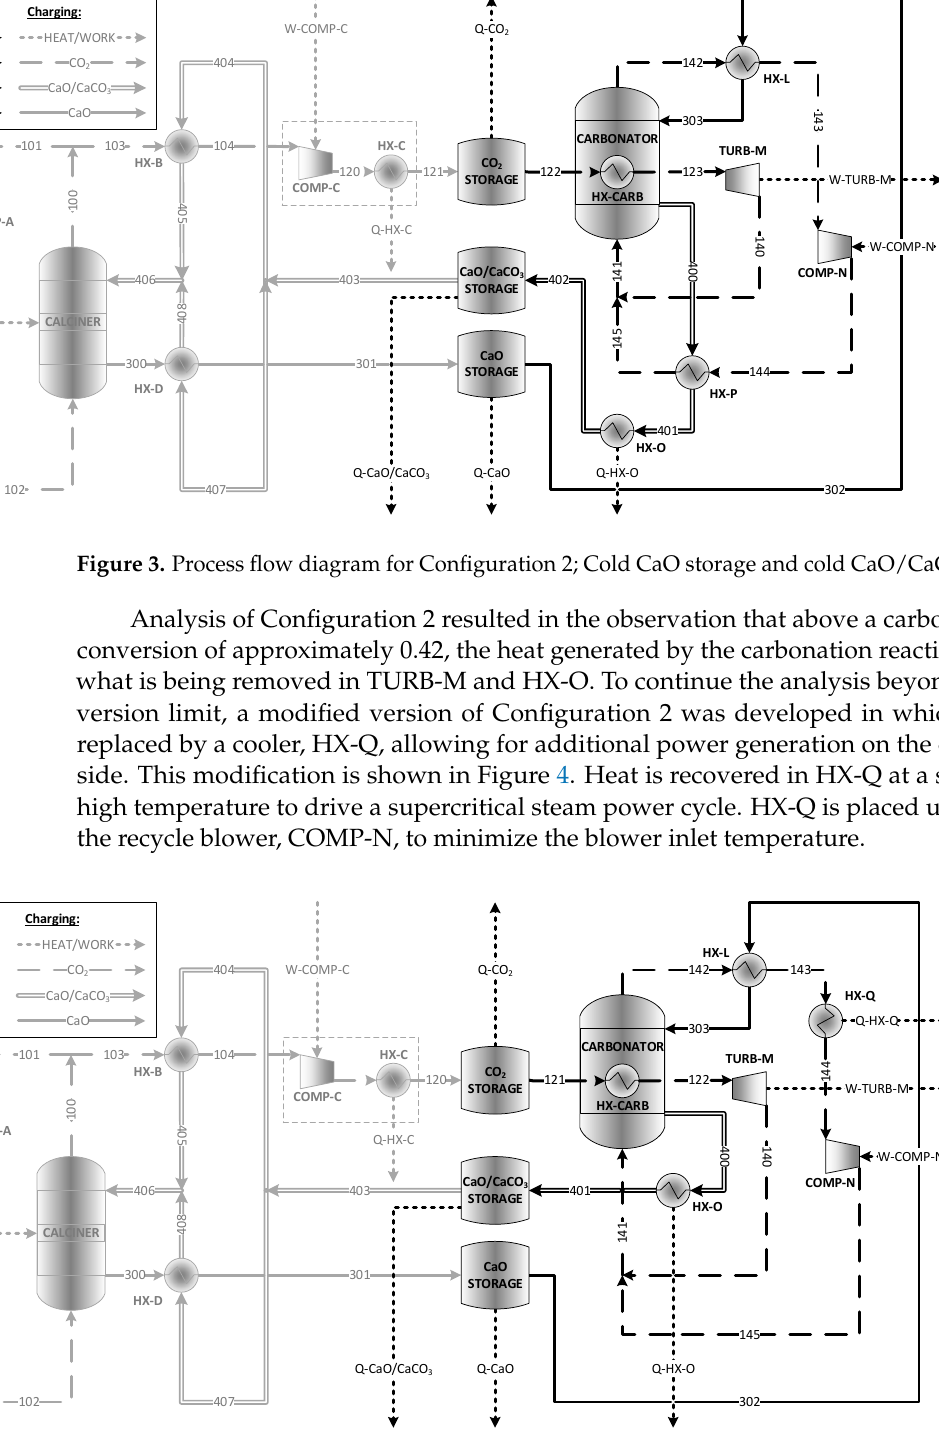
Figure 4. Process fl ow diagram for modi fi ed Con fi guration 2.